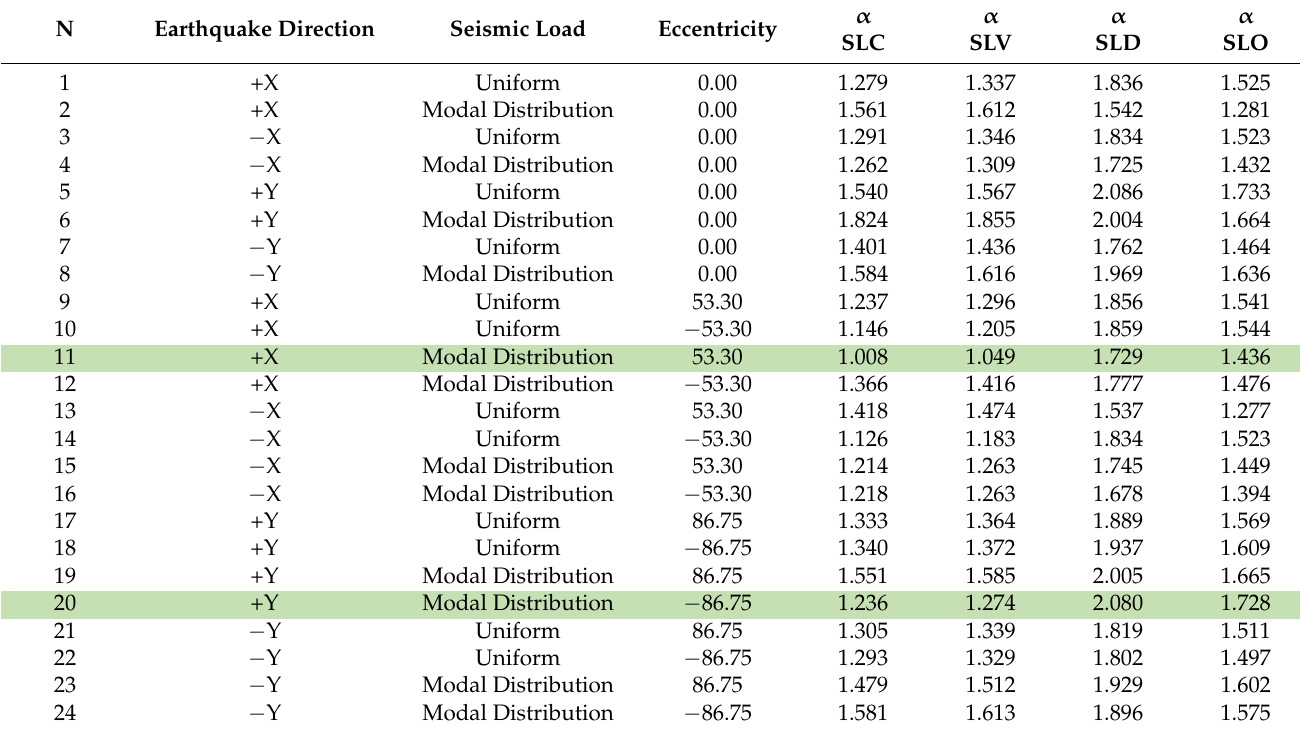
Table 5. Results of pushover analyses on the retrofitted